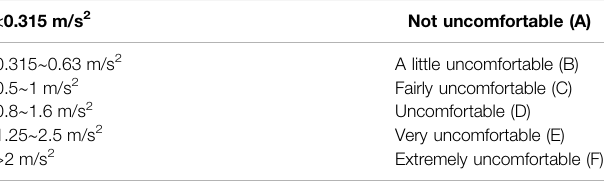
TABLE 1 | Approximate indications of likely reactions to various magnitudes of vibration. < 0.315 m/s 2